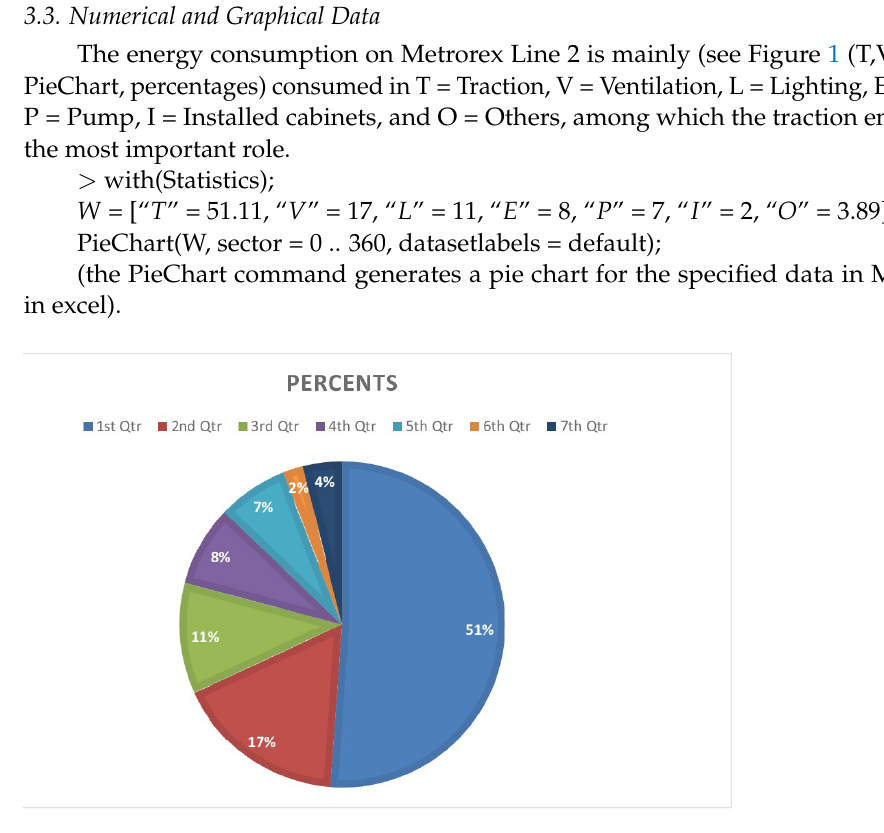
Figure 1. Energy consumption on Metrorex Line 2.